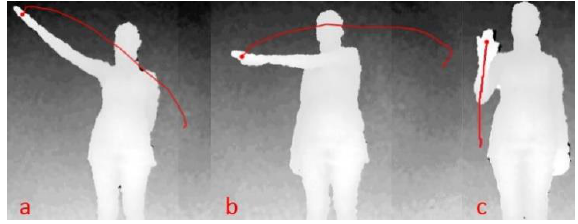
Fig. 4. Movements used to control the GesturePuzzle application: (a) diagonal, (b) transverse and (c) sagittal. If the user presents a limitation of the upper limbs motion, it is possible to reduce the range of movement by approximating the sensor to the user and, consequently, a shorter action is required to move the pieces on the